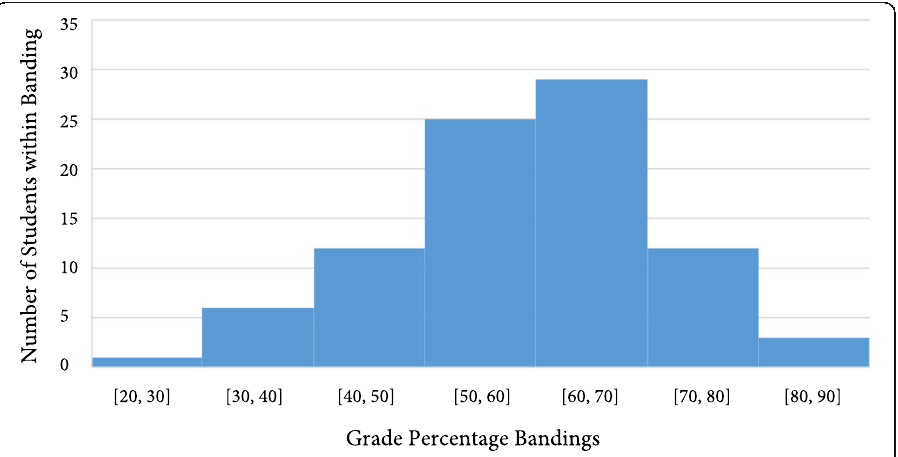
Fig. 1 Histogram displaying distribution of grades within the Online Open Book Essay